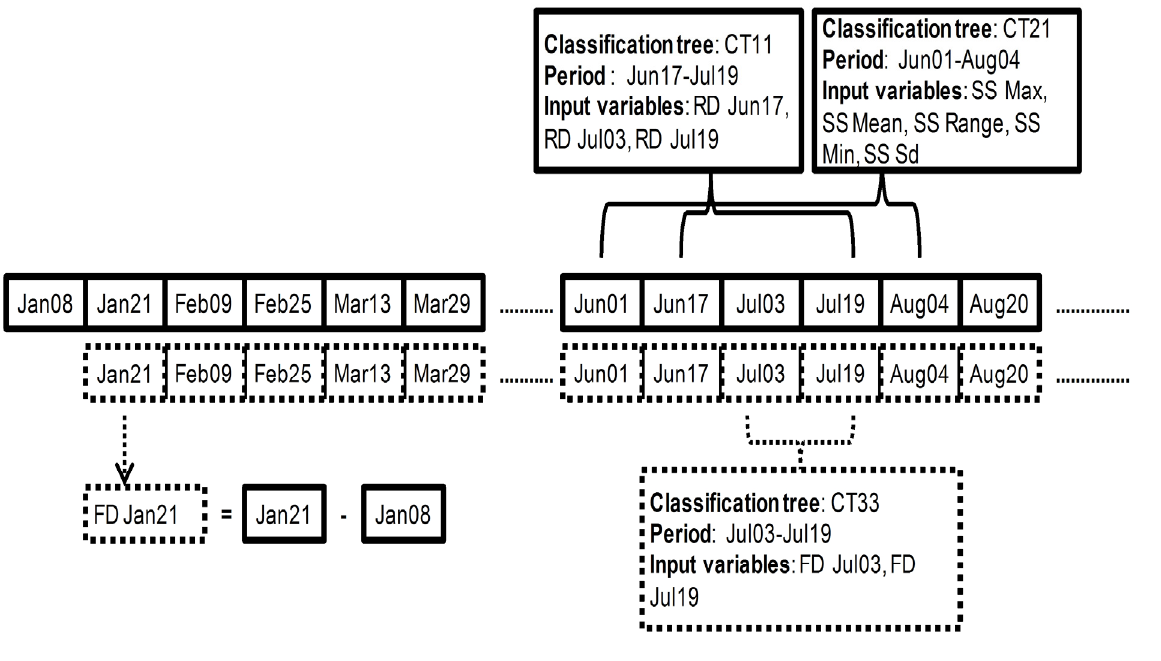
Figure 4. First difference transformation, notation and selection of input variables for the respective classification run. Solid line—raw data (RD), dotted line—first difference transformed data (FD).